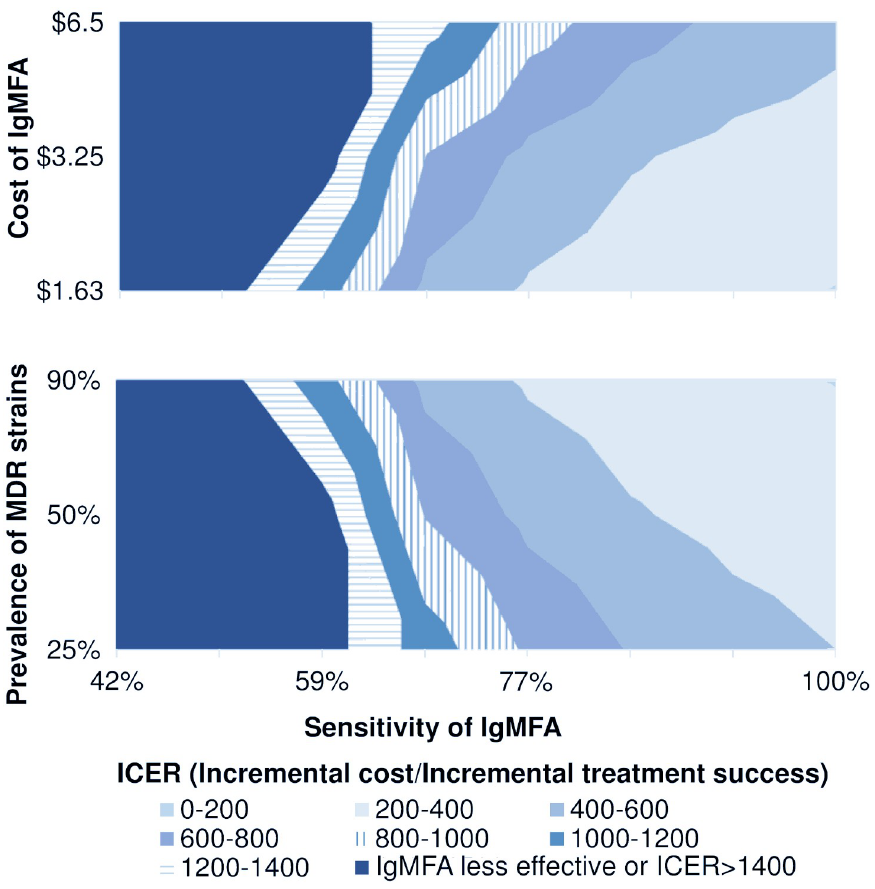
Fig 3. ICER distributions in two-way sensitivity